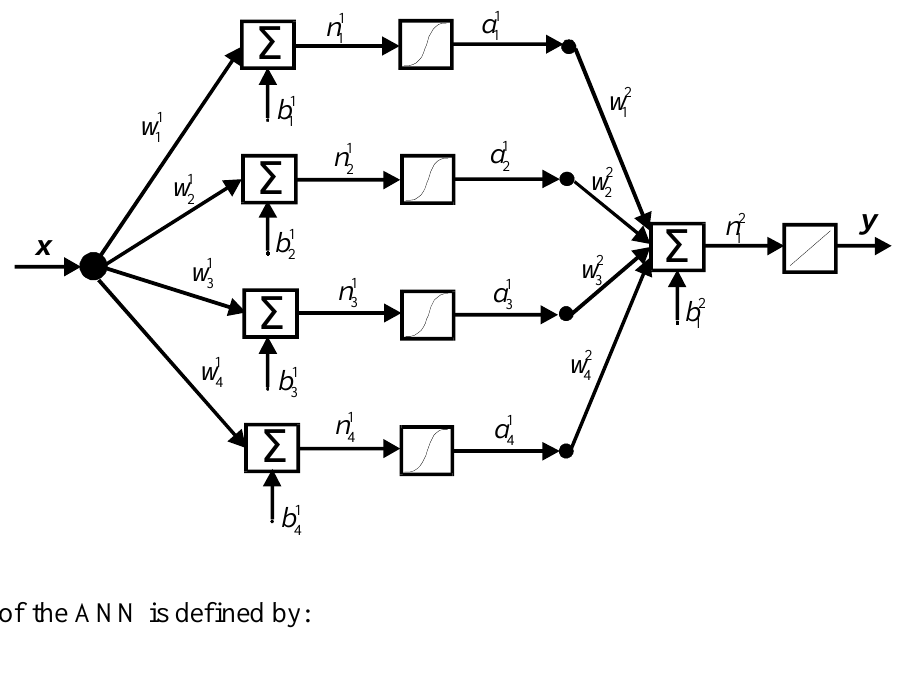
Figure 1. Architecture of the artificial neural